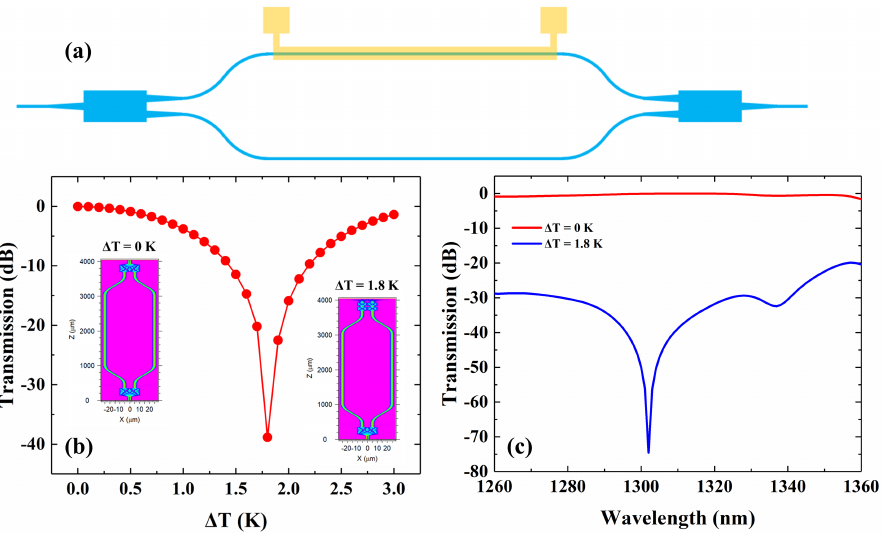
Figure 2. ( a ) The schematic of the VOA; ( b ) Calculated transmission versus modulation arm tem- perature change; ( c ) Calculated spectra of the VOA, while the temperature change of the modulation arm is 0 K and 1.8